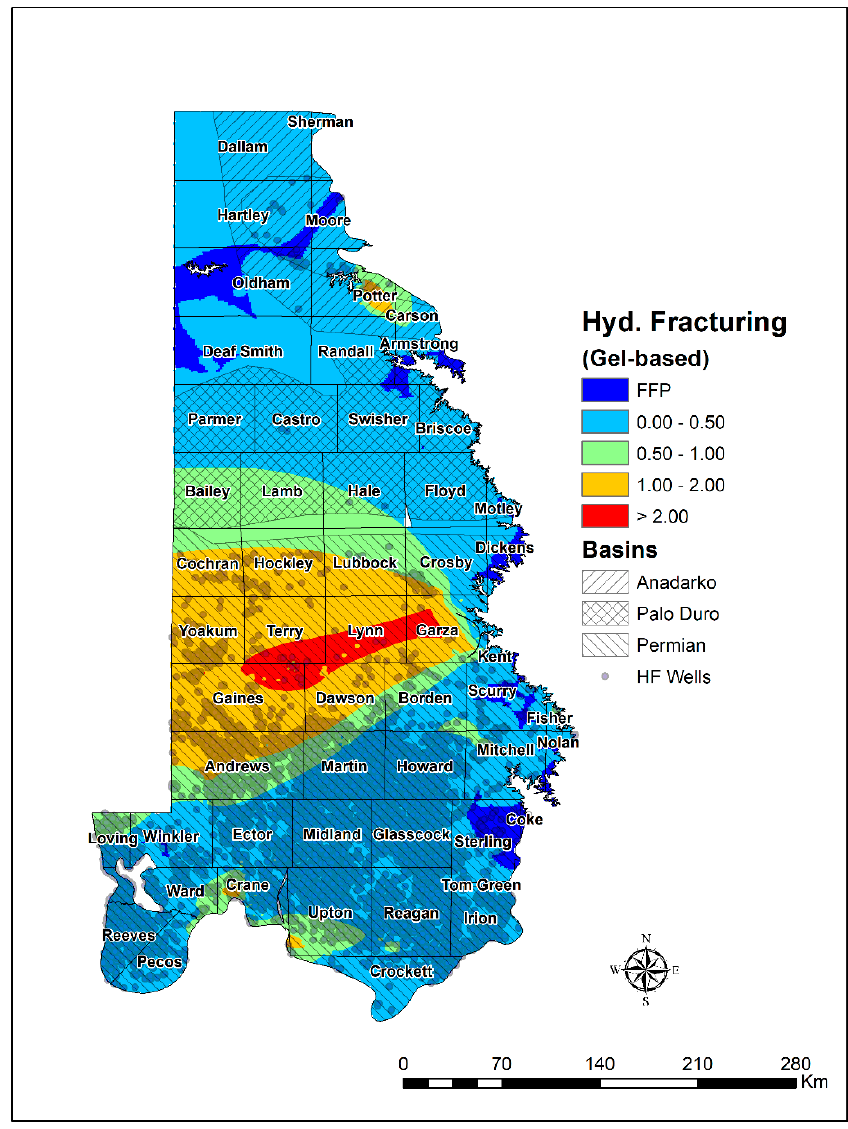
Figure 8. Overall Compatibility Index (OCI) for gel-based hydraulic fracturing.